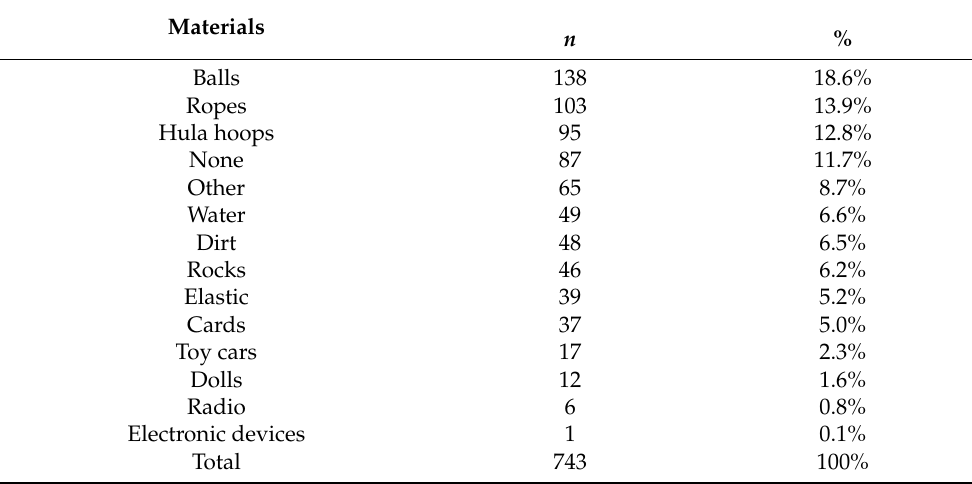
Table A5. Materials used by children in primary schools’ recess in the pandemic.